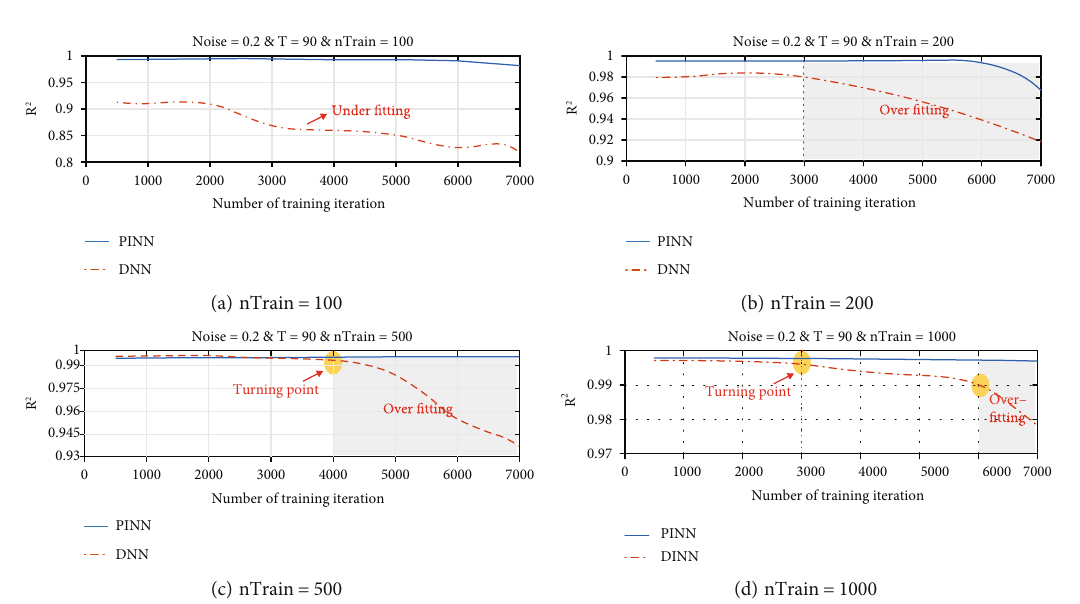
Figure 8: The e ff ect of training